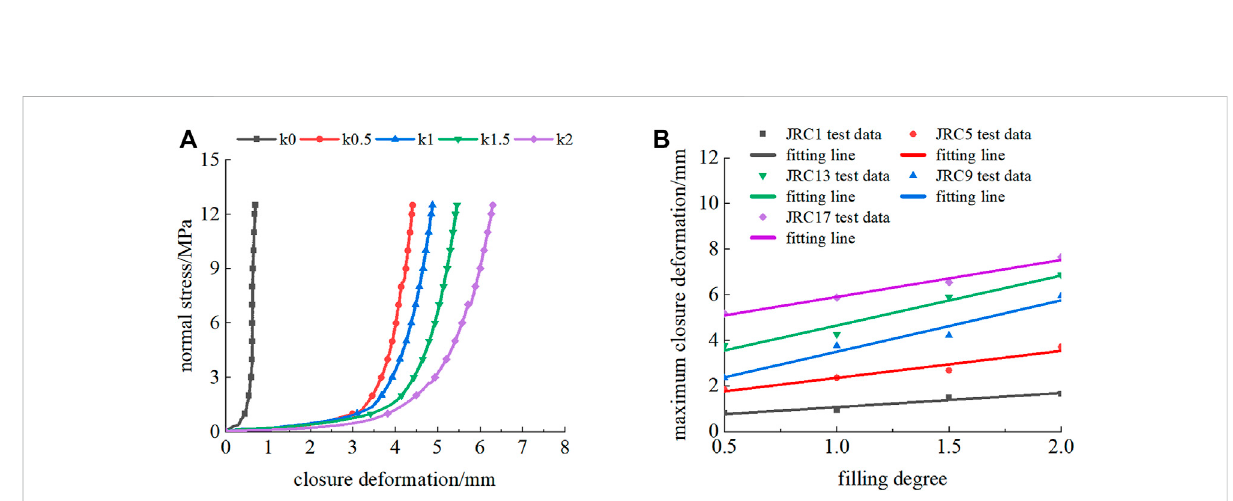
FIGURE 15 Effectofthedegreeof fi llingonthenormalclosuredeformationcharacteristicsofarockjoint: (A) normalstress-closuredeformationcurveofa fi lled rock joint (JRC=17) and (B) maximum closure deformation- fi lling degree curve.